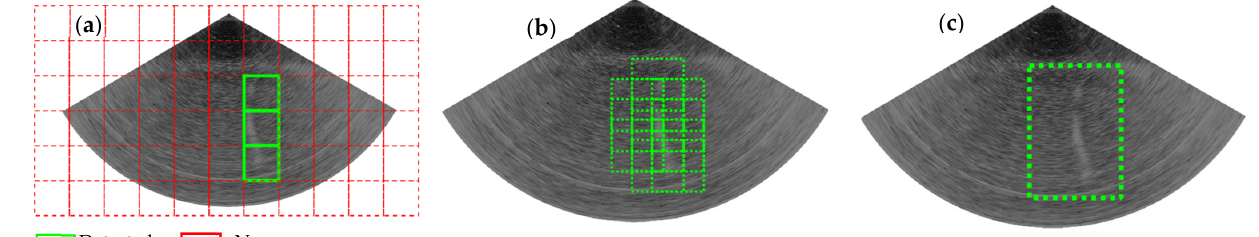
Figure 13. Target detection results using fix anchor boxes ( a ) and moving anchor boxes ( b ). ( c ) is the maximum boundary of ( b ).